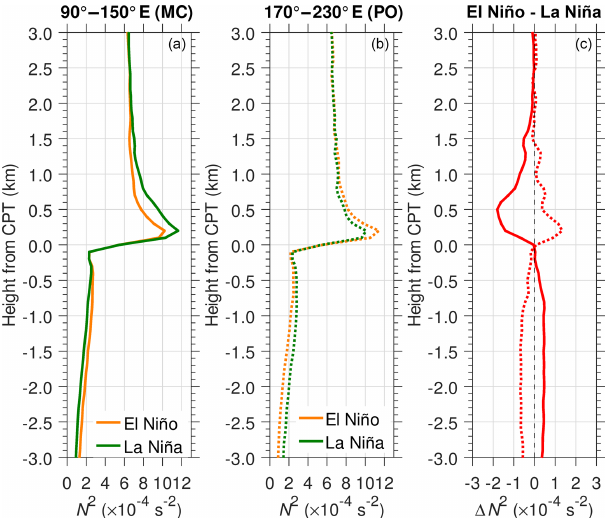
Figure 11. Mean N 2 profiles during DJF El Niño (a) and DJF La Niña (b) . Difference between the mean N 2 in DJF El Niño and in DJF La Niña (c) in the MC (solid line) and PO (dotted